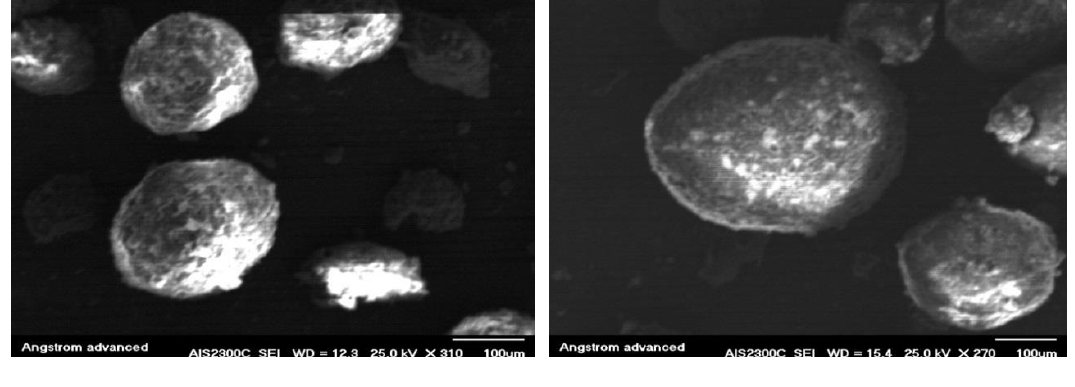
Figure (5) SEM of the selected microsponge formula BF14 at (A) 310 X magnification and (B) 270 X